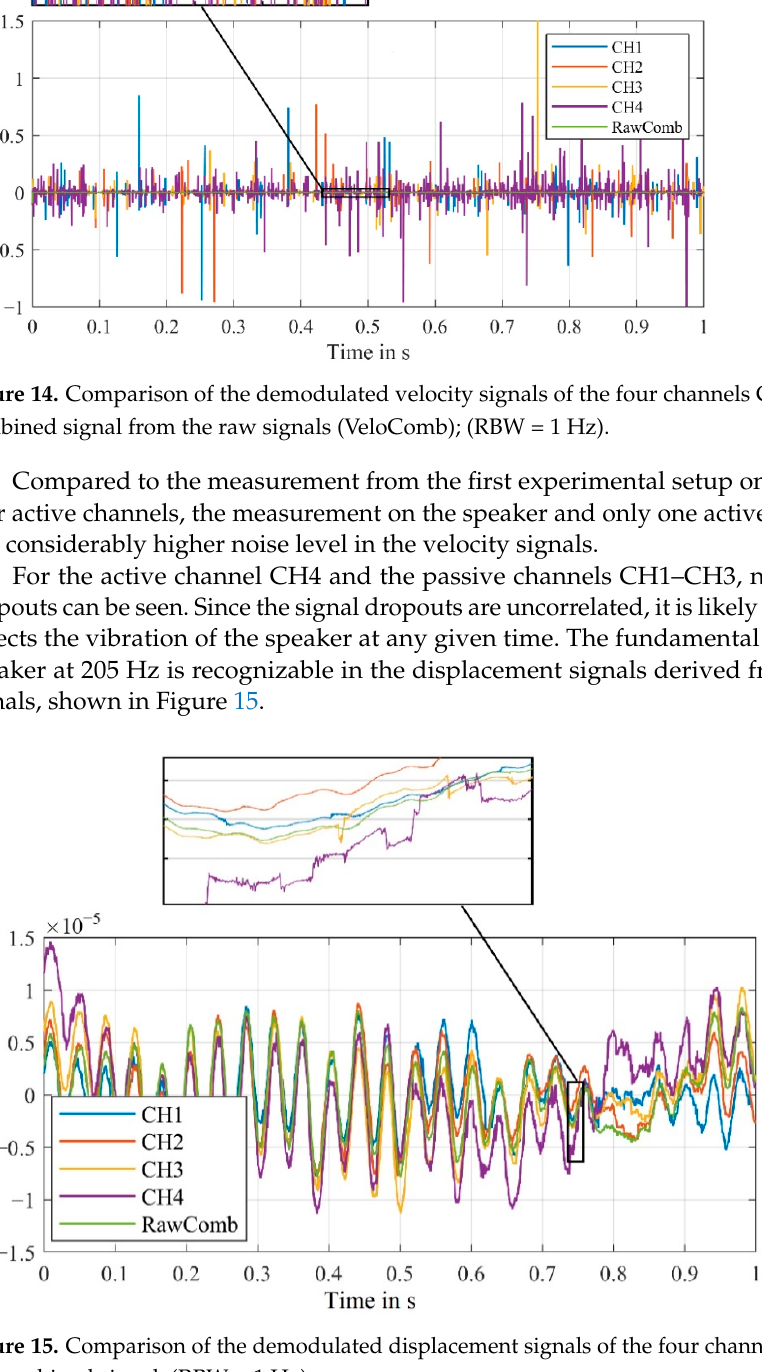
Figure 16. Comparison of the frequency spectra of the four channels CH1–CH4 and combined signal, one section of the spectra is shown smoothed for better visualization; (RBW = 1 Hz). Due to the lower noise level of combined signal, the functionality of the algorithm can be shown. The relatively large amplitude of the speaker’s vibration frequency is detected almost identically by all signals. With these results, we can demonstrate that the algorithm yields good results for close to real-world applications. For this measurement, the mean noise level in the frequency range up to 5000 Hz of the combined signal (RawComb) was reduced by 10 dB compared to the mean noise level of the signals of the individual channels.